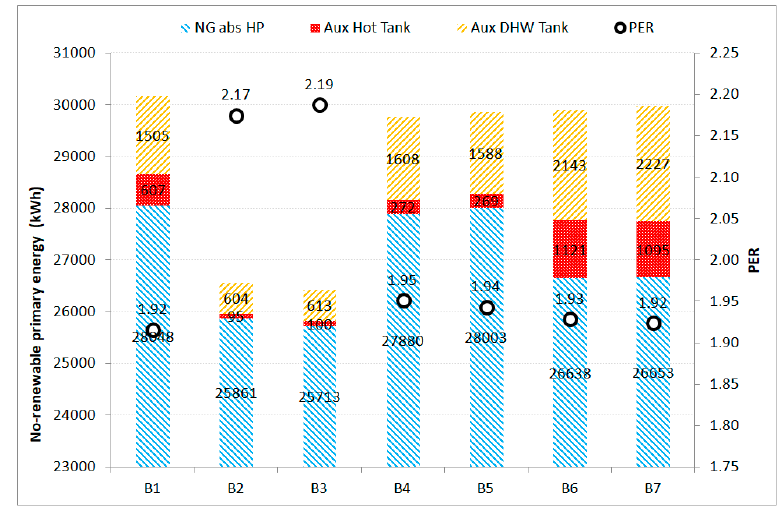
Figure 18. No-renewable primary energy consumption and primary energy ratio for the different alternatives.